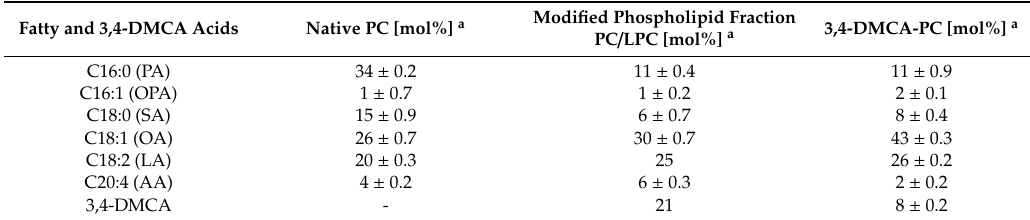
Table 3. Fatty acid composition (% according to gas chromatography (GC)) of phospholipid fractions obtained of interesterification reaction of egg-yolk PC with